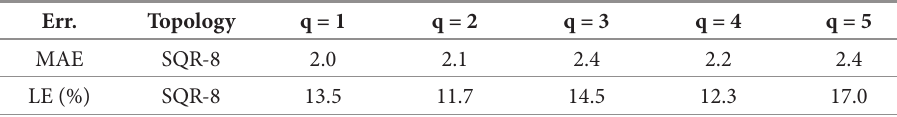
Table 3. On-line Mean Absolute Error – MAE and LE